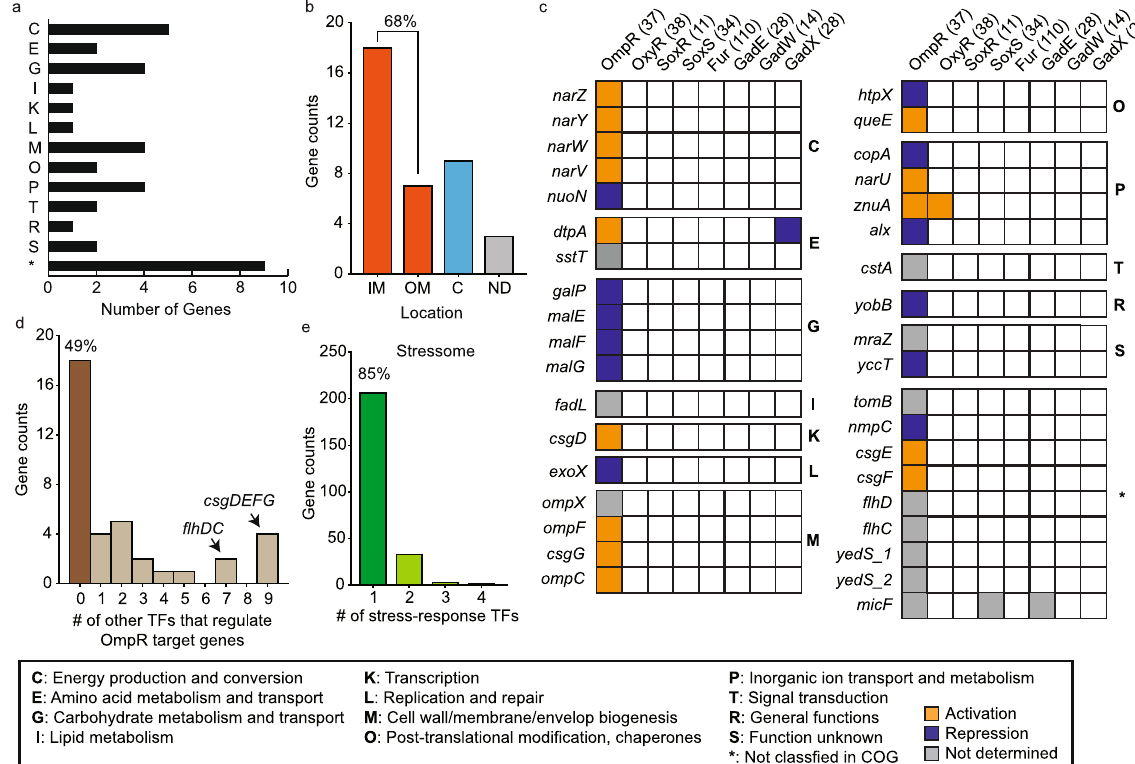
Figure 3. Functional delineation of OmpR regulon and its interaction with other TFs. ( a ) Functional classification (COG) of OmpR regulon. ( b ) Distribution of functional location of gene products of OmpR regulon. IM; inner membrane, OM; outer membrane, C; cytosol, ND; not determined. ( c ) Integration of the OmpR regulon information (37 target genes) with other publicly available regulon information of stress- responsive TFs for oxidative stress (OxyR, SoxR, and SoxS), iron imbalance stress (Fur), and acid stress (GadE, GadW, and GadX). The 37 target genes were categorized into 13 groups based on their COG functional annotations. The amber and dark blue boxes indicate activation and repression of transcription by direct association of OmpR, respectively. The grey box indicates that the transcription regulation could not be determined though the direct association of OmpR. ( d ) The distribution of the number of OmpR target genes regulated by other TFs among the entire set of TFs. ( e ) The distribution of 243 genes consisted of regulon members of 8 different stress-response TFs according to the number of stress-response TFs regulating those